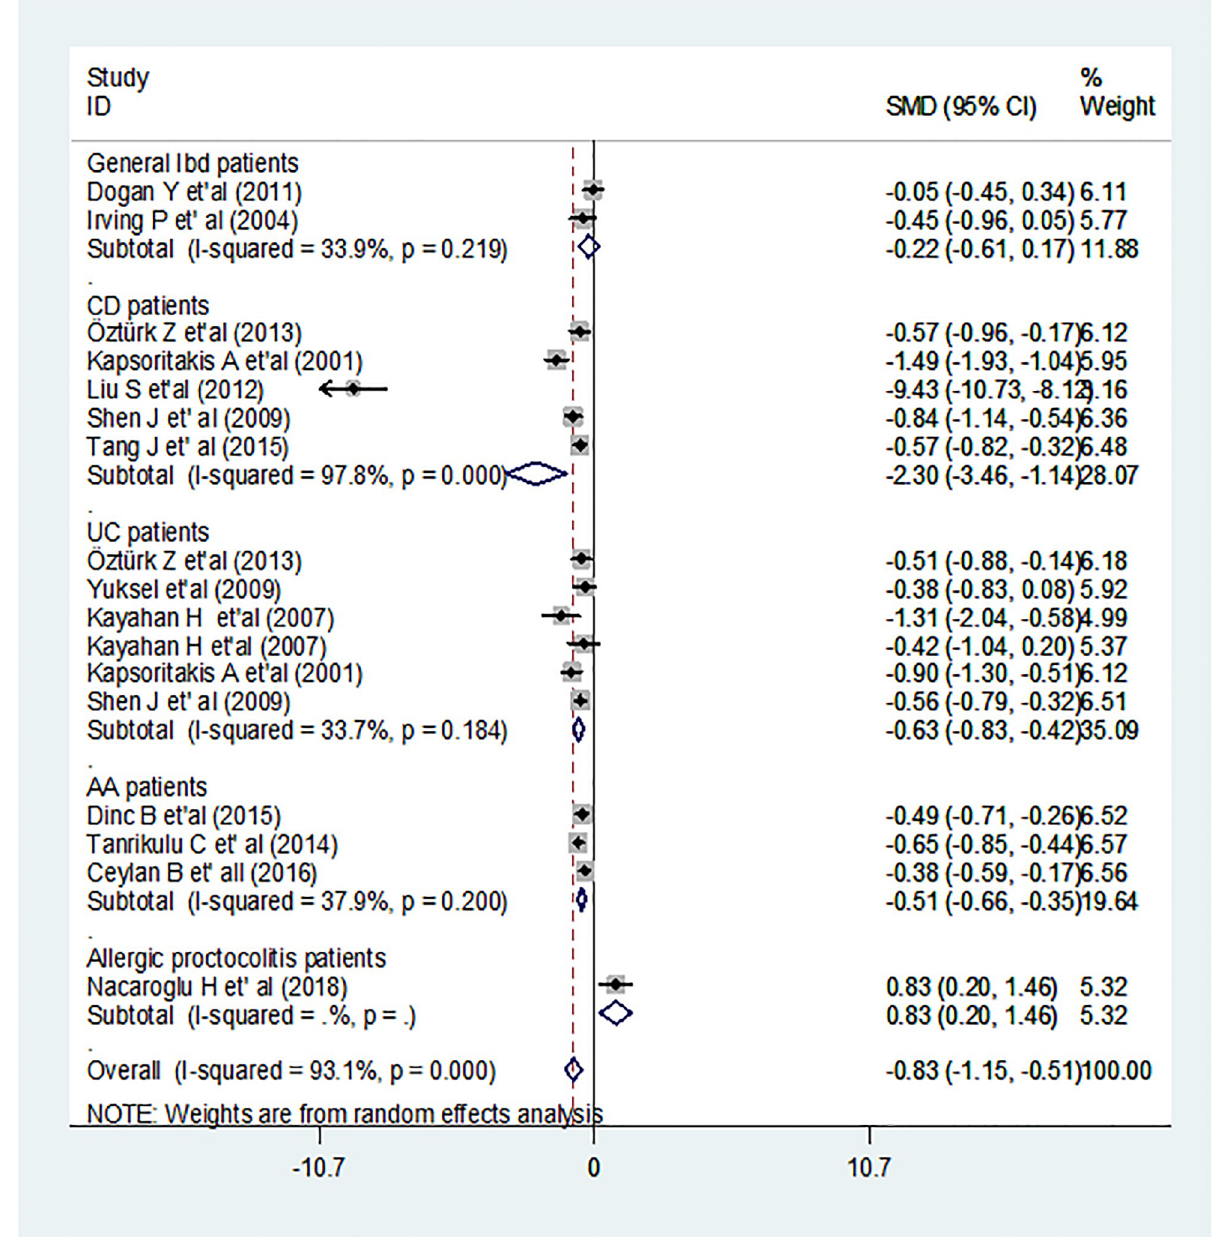
Fig 6. Forest plot of population based sub-group analysis. The x-axis scale displays the estimation of the SMD in MPV. The hard line shows no difference. The dotted line represents the mean difference in the pooled point estimate of each study. In the center of the gray box, the black dot reflects the SMD estimate of each article’s point estimate and the line shows the 95% CI of the estimates. I-squared indicates the heterogeneity across the included studies, p indicating for statistical significance of